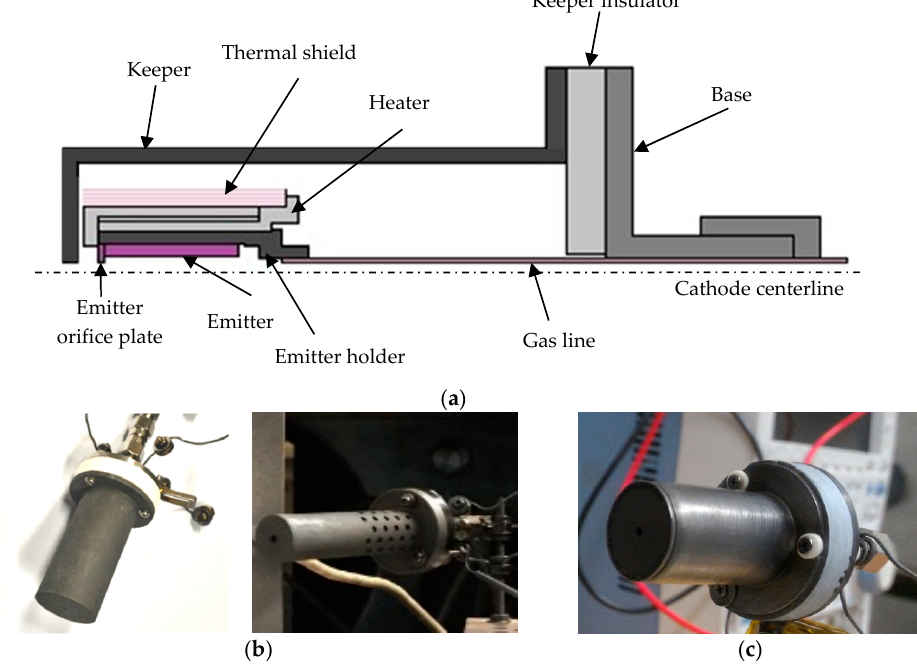
Figure 10. PSAC 1 A-class cathode: ( a ) schematic [51]; (b) various designs with a graphite keeper electrode; ( c ) with a stainless steel shorter keeper electrode and a graphite keeper orifice plate.